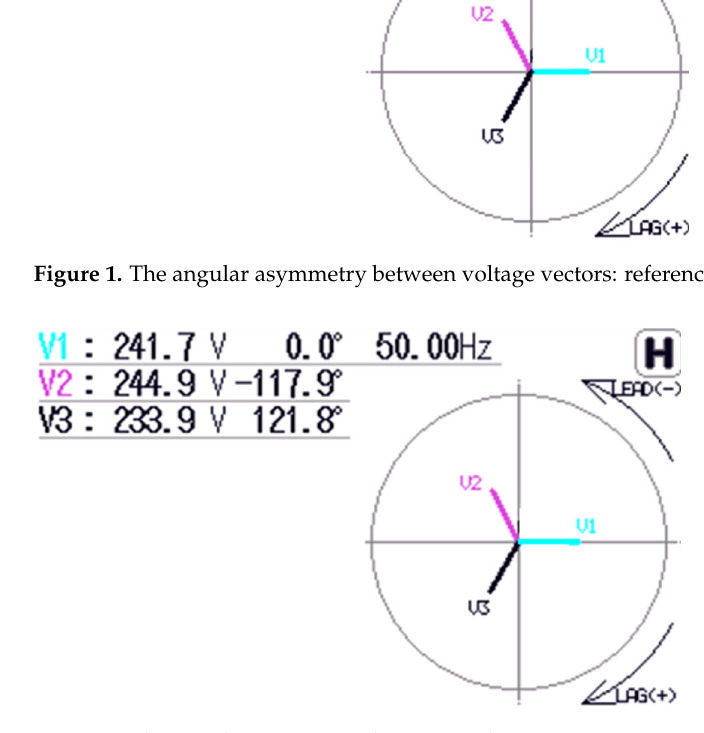
Figure 2. The angular asymmetry between voltage vectors: microgrid measurement.